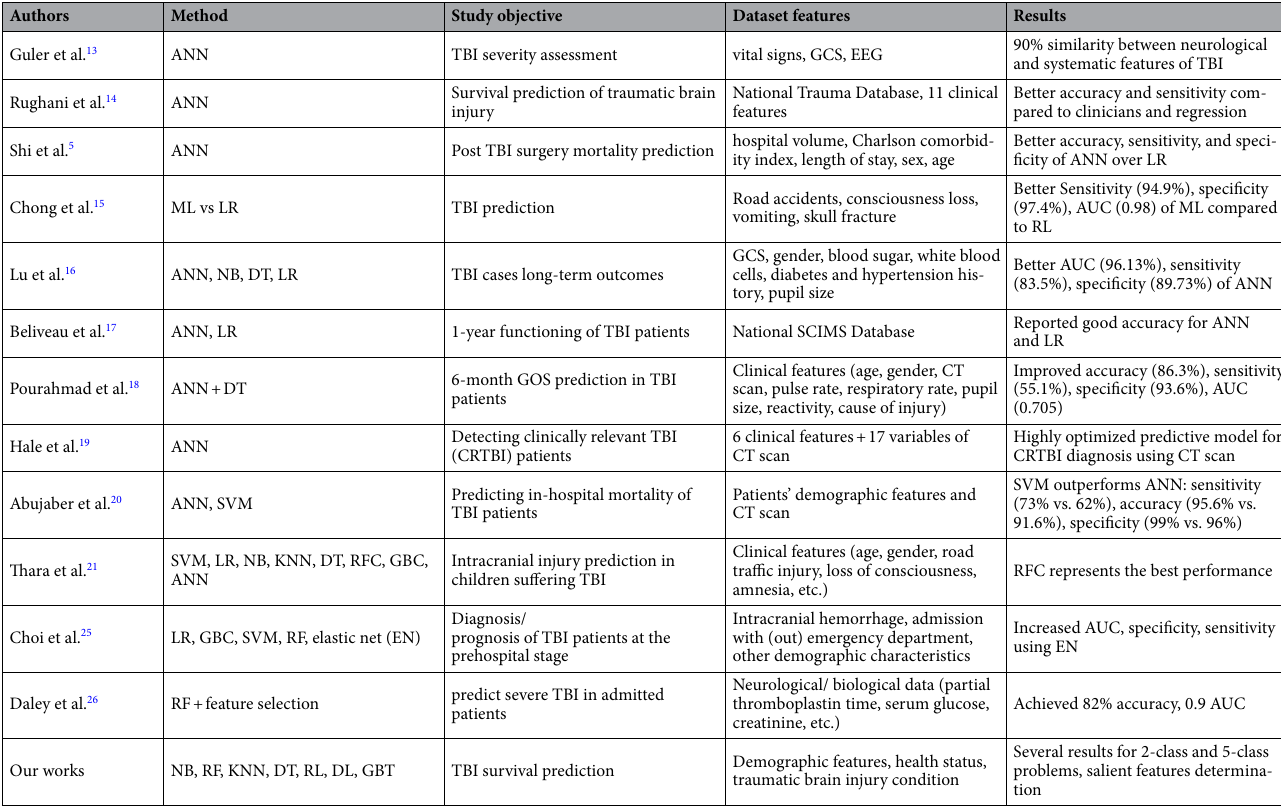
Table 13. Comparison of our work with the existing ML methods developed for automated detection of